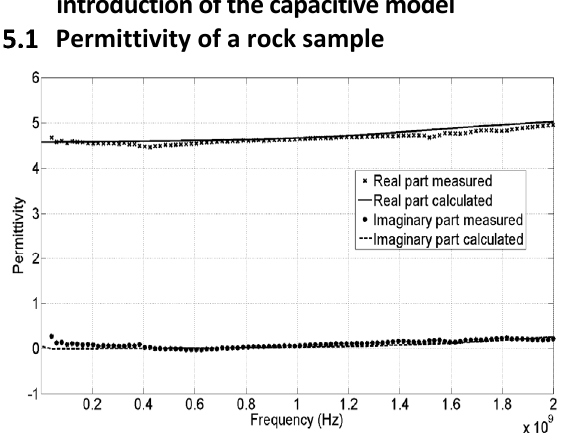
Figure 13. Measurement of the real and imaginary parts of the permittivity of an aggregate sample compared to a 4.6 permittivity simulated material.